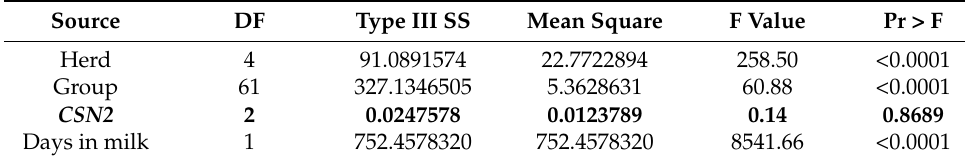
Table 10. Linear model (dependent variable: fat